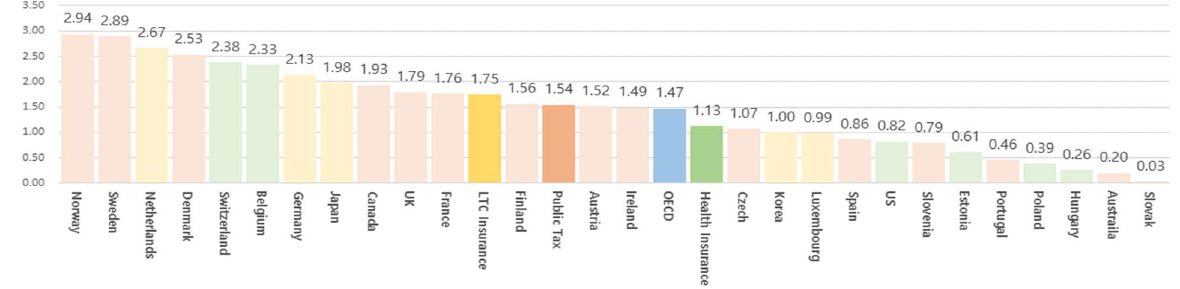
Figure 2. Status of long-term care expenditure as a percentage of GDP in 26 OECD countries (2019). Source: OECD Health Statistics [18].